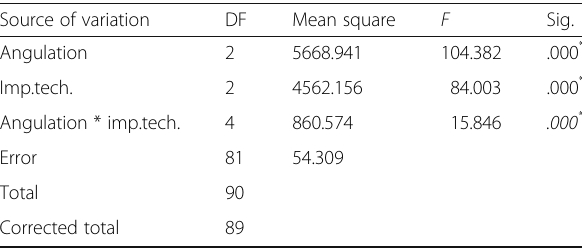
Table 5 Effect of implant angulation and impression technique on impressions by two-way ANOVA for Δ r 1 Source of variation DF Mean square F